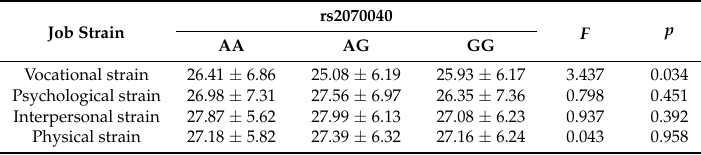
Table 8. Association between rs2070040 polymorphism and job strain